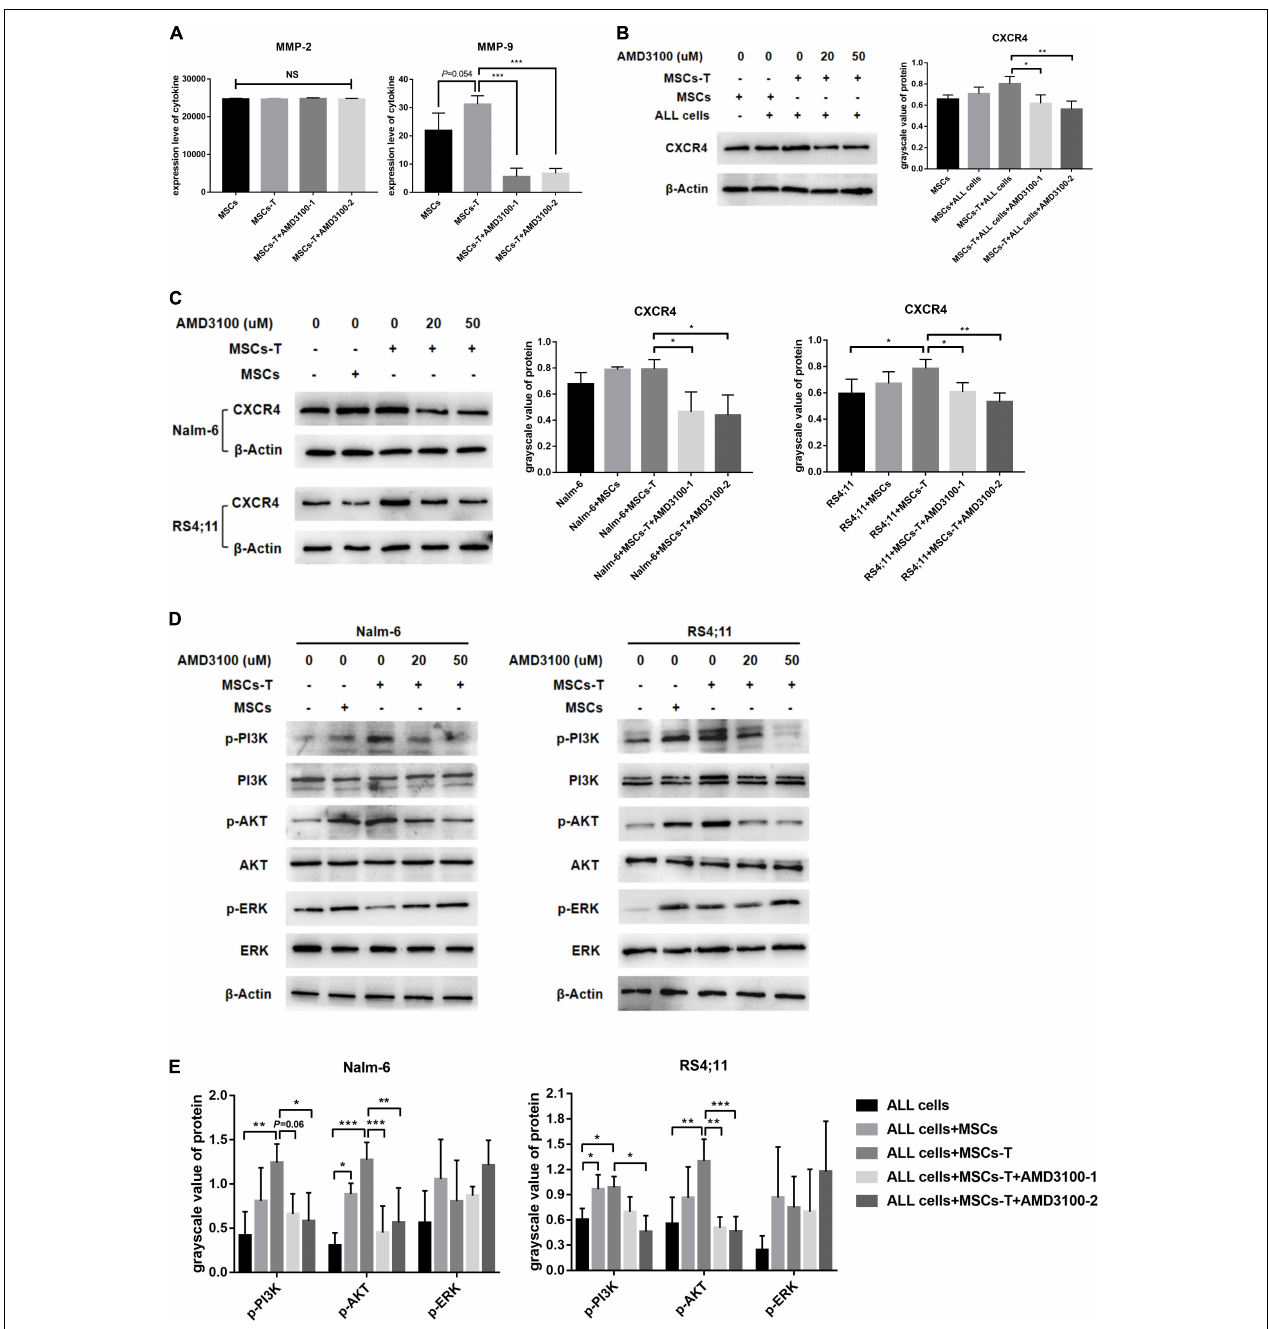
FIGURE 3 | AMD3100 inhibited the secretion of MMP-9 in MSCs with CAF-like phenotype, and inhibited the activation of PI3K/AKT signaling pathway in ALL cells. (A) ELISA showing the supernatant expression of MMP-2 (pg/ml) and MMP-9 (pg/ml) in the medium of MSCs, TGF- β conditioned MSCs, TGF- β conditioned MSCs + AMD3100-1 (20 µ M) and TGF- β conditioned MSCs + AMD3100-2 (50 µ M). (B) The expression of CXCR4 in the stromal cells of MSCs group, MSCs + ALL cells group, TGF- β conditioned MSCs + ALL cells group, TGF- β conditioned MSCs + ALL cells + AMD3100-1 (20 µ M) group and TGF- β conditioned MSCs + ALL cells + AMD3100-2 (50 µ M) group by western blot after culturing 24 h. (C) The expression of CXCR4 in Nalm-6/RS4;11 cells from individual culture and co-culture with MSCs, TGF- β conditioned MSCs, TGF- β conditioned MSCs + AMD3100-1 (20 µ M) and TGF- β conditioned MSCs + AMD3100-2 (50 µ M) for 24 h by western blot. (D) The expression of p-PI3K, p-AKT, and p-ERK in Nalm-6/RS4;11 cells from individual culture and co-culture with MSCs, TGF- β conditioned MSCs, TGF- β conditioned MSCs + AMD3100-1 (20 µ M) and TGF- β conditioned MSCs + AMD3100-2 (50 µ M) for 24 h. (E) Gray value analysis of p-PI3K, p-AKT, and p-ERK signal pathways expressed in the above five groups, with the total protein corresponding to the phosphorylated protein as an internal control. Each value indicates the mean ± SD of three or more independent experiments. In each independent repeated experiment, MSCs was isolated and cultured from a B-ALL patient, and stimulated with rhTGF- β to obtain the CAF-like phenotype, then the latter were compared with the untreated MSCs from the same patient to ensure that the experiment was comparable. * P < 0.05, ** P < 0.01, *** P < 0.001.